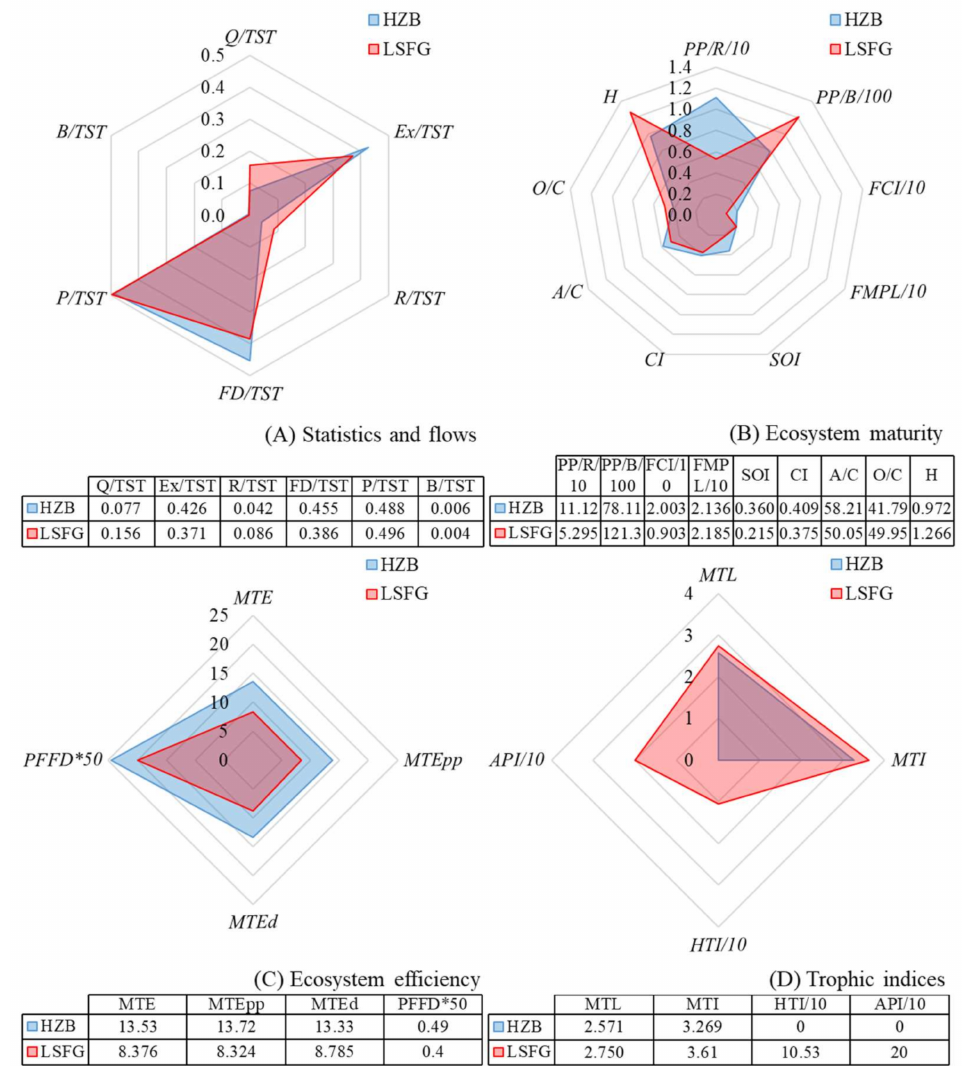
Figure 4. Radial plot of ecological indicators of the HZB (blue) and LSFG (red) ecosystems. Note: Acronyms and their full names are shown in Table 1. ( A ) Statistics and flows; ( B ) Ecosystem maturity; ( C ) Ecosystem efficiency; ( D ) Trophic